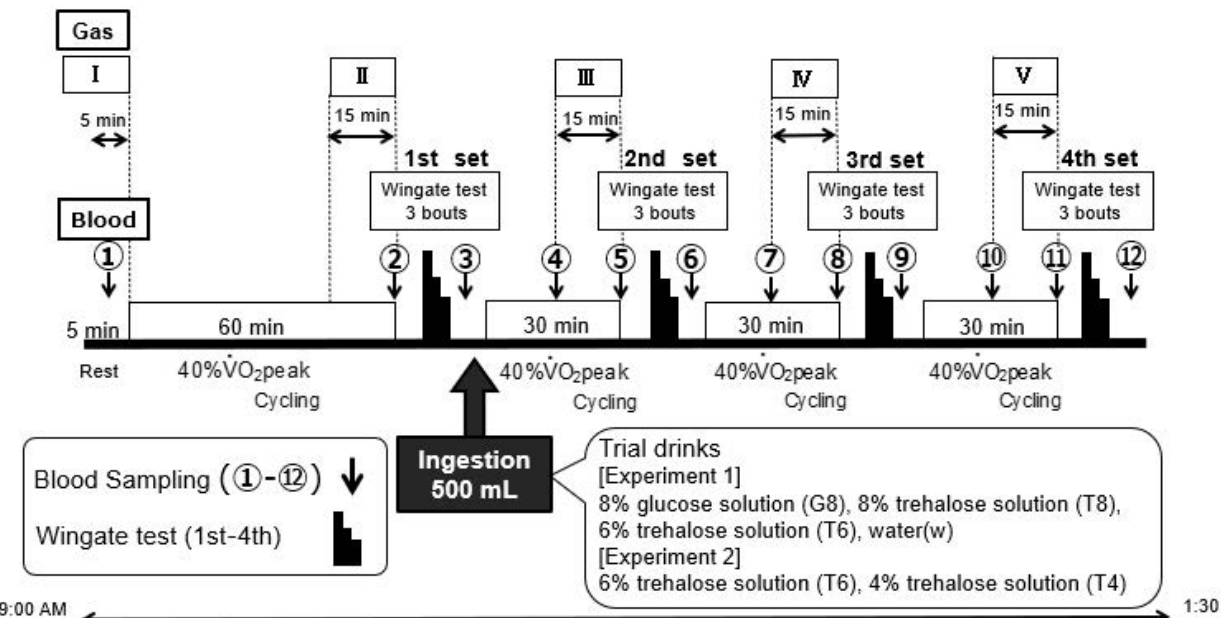
Figure 1. Experimental design (Wadazumi protocol). This cycling exercise protocol combines constant-load exercise and the Wingate test. Intensity of constant load was set at 40% 60 min and 30 min × 3 times. Four sets of the Wingate test (30 s × 3 times) were performed. After the first Wingate test, participants ingested a trial drink. Expired gas was collected at rest (I) and in last 15 min of 60 and 30 min constant-load exercise (II–V). Points 1 (cid:13) to 12 (cid:13) indicate blood sample collection, RPE measurements, and Borg scale measurements.